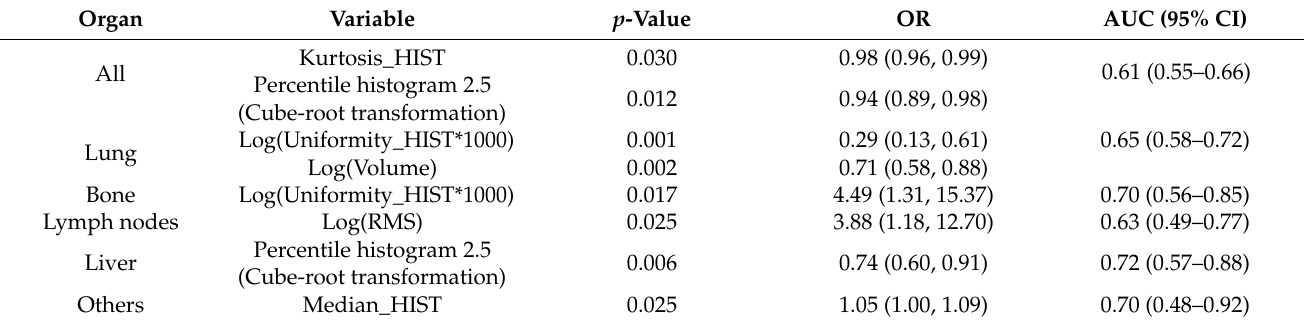
Table 1. Multivariate analysis of radiomics data according to